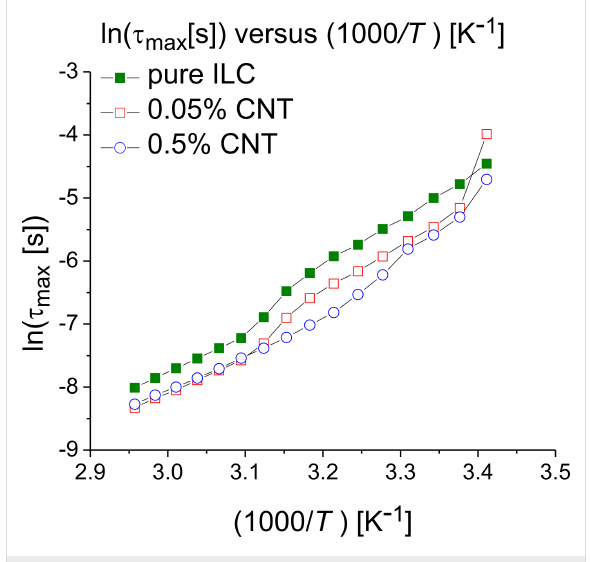
Figure 7: Relaxation time as function of the inverse temperature (loga- rithm scale) for pure ILC (green solid squares), ILC doped with 0.05% CNTs (red open squares) and ILC doped with 0.5% CNTs (blue open